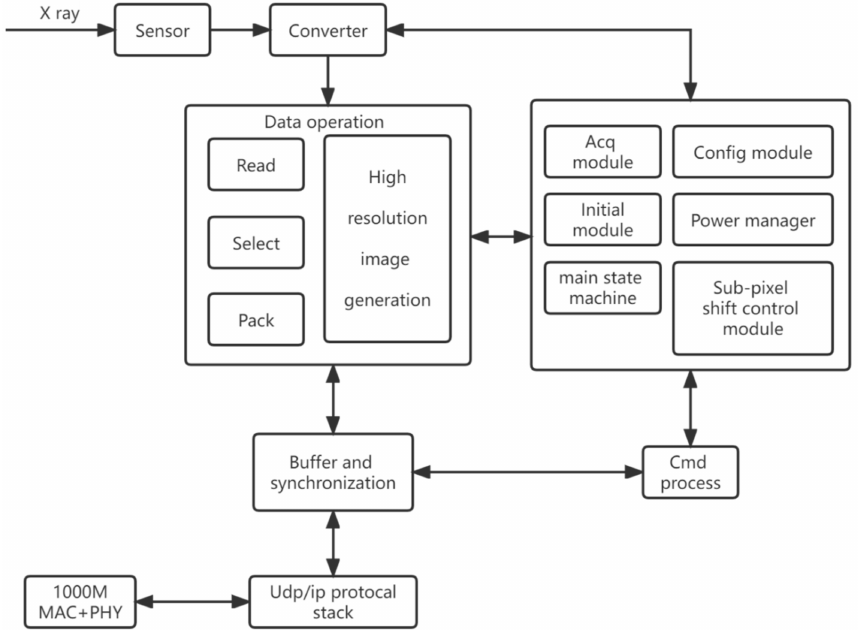
Figure 4. The entire architecture of our novel